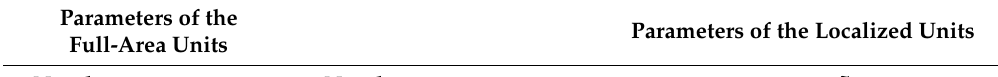
Table 4. The design parameter of the end wall contouring for the stator.